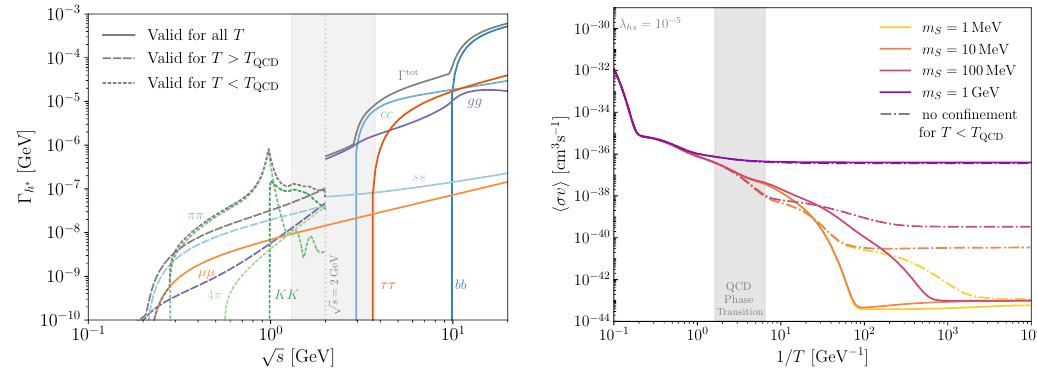
Figure 3 . Left: partial decay widths of an off-shell SM Higgs boson as a function of the CMS energy. √ For s < 2 GeV we use the decay widths into hadrons from ref. [60] for T < T QCD (short-dashed lines) and leading-order estimates of the decay widths into free quarks and gluons for T > T QCD (long-dashed lines). For higher CMS energies we use the results from HDECAY [54] based on the assumption of free quarks and gluons in the final states and including higher-order corrections (solid lines). In the grey area the decay widths suffer from significant uncertainties due to the transition between the two regimes, see text for details. Right: thermally averaged annihilation cross section as a function of inverse temperature, including quantum statistics and for DM masses as indicated. Solid lines show the result obtained when using hadronic final states for the off-shell Higgs decay widths for T < T QCD , while dot-dashed lines result from (incorrectly) assuming decays into free quarks even below the QCD phase transition (indicated by the grey